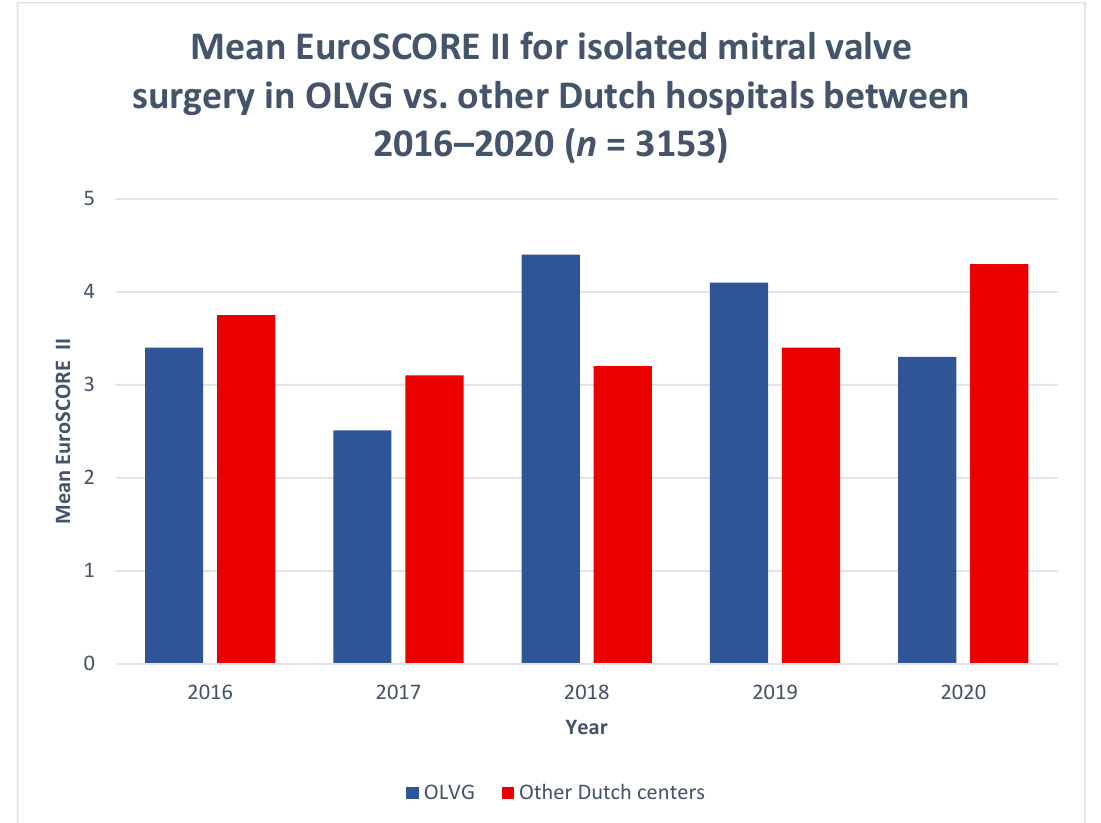
Figure 1. Comparison between the OLVG preoperative mean EuroSCORE II vs. other Dutch hospitals. Table 1. Summary of perioperative variables in the MIMVS isolated mitral group.